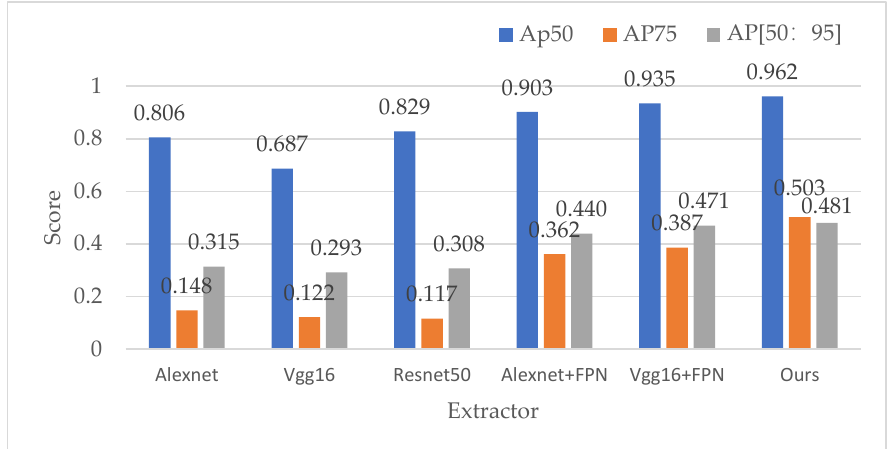
Figure 21. The comparison results of the proposed method with Faster-RCNN based on other extractors.